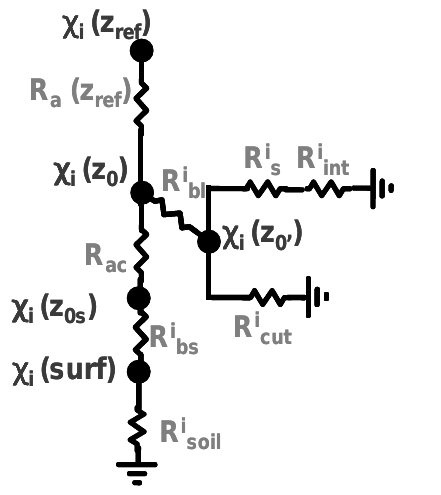
Figure 1: Resistive scheme used in the Surfatm model for pollutant exchange. χ is the gas concentration. R a , R ac , R bl , R bs , R s , R int , R cut and R soil are aerodynamic resistance above the canopy, aerodynamic resistance within the canopy, leaf quasi-laminar boundary layer resistance, soil quasi-laminar boundary layer resistance, stomatal resistance, internal resistance, cuticular resistance and soil resistance, respectively. Indexes i , z ref , z 0 , z 0’ , z 0s and “surf” indicate the gas considered, the reference height, the canopy roughness height for momentum, the canopy roughness height for scalar, the soil roughness height for momentum, and the soil surface, respectively.